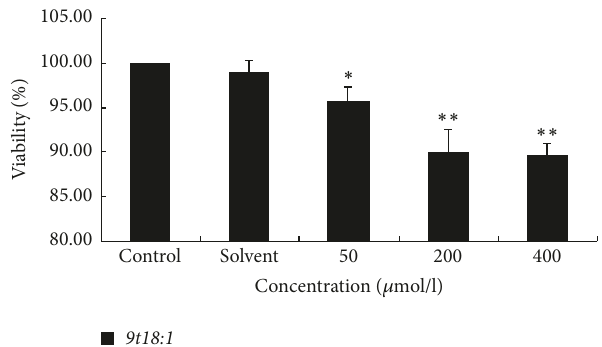
Figure 1: Effect of elaidic acid on cell viability. Control: medium without cells; Solvent: HUVEC treated with 200 𝜇 mol/l sodium hydroxide; 50: HUVEC treated with 50 𝜇 mol/L elaidic acid; 200: HUVEC treated with 200 𝜇 mol/L elaidic acid; 400: HUVEC treated with 400 𝜇 mol/L elaidic acid. ∗ indicated a significant difference (𝑝 < 0.05) , ∗∗ indicated a significant difference (𝑝 < 0.01) .